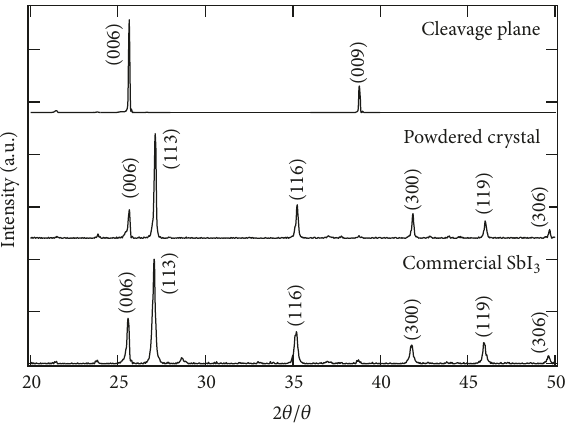
Figure 5: X-ray diffraction patterns of the grown SbI 3 crystal and a commercially available SbI 3